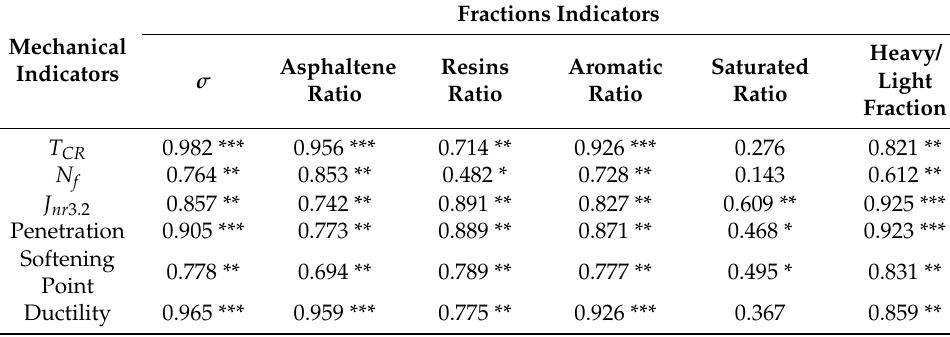
Table 5. Correlation of the mechanical and fraction